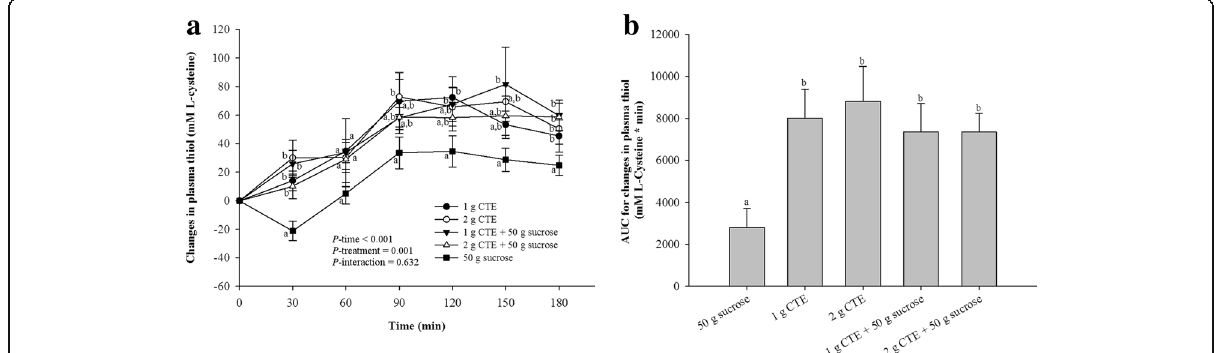
Fig. 6 Postprandial plasma thiol of five different beverages. a Changes in plasma thiol concentrations during 180 min of five different beverages; ( b ) Thiol changes area under the curves (AUCs) of five different beverages. Values are means ± SEM, n = 15. Different letters are significantly different ( P <